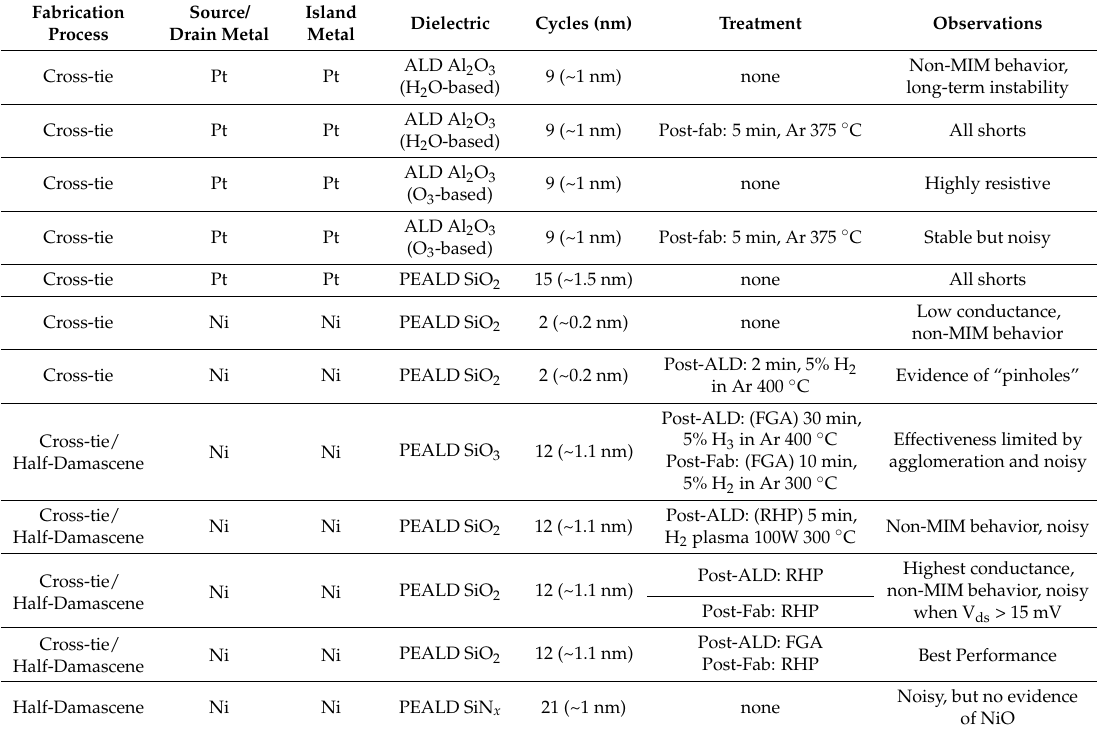
Table 1. Summary of SET fabrication processes, treatments, and observations. Post-fab indicates a treatment after fabrication and post-ALD indicates a treatment after the respective ALD process. Fabrication